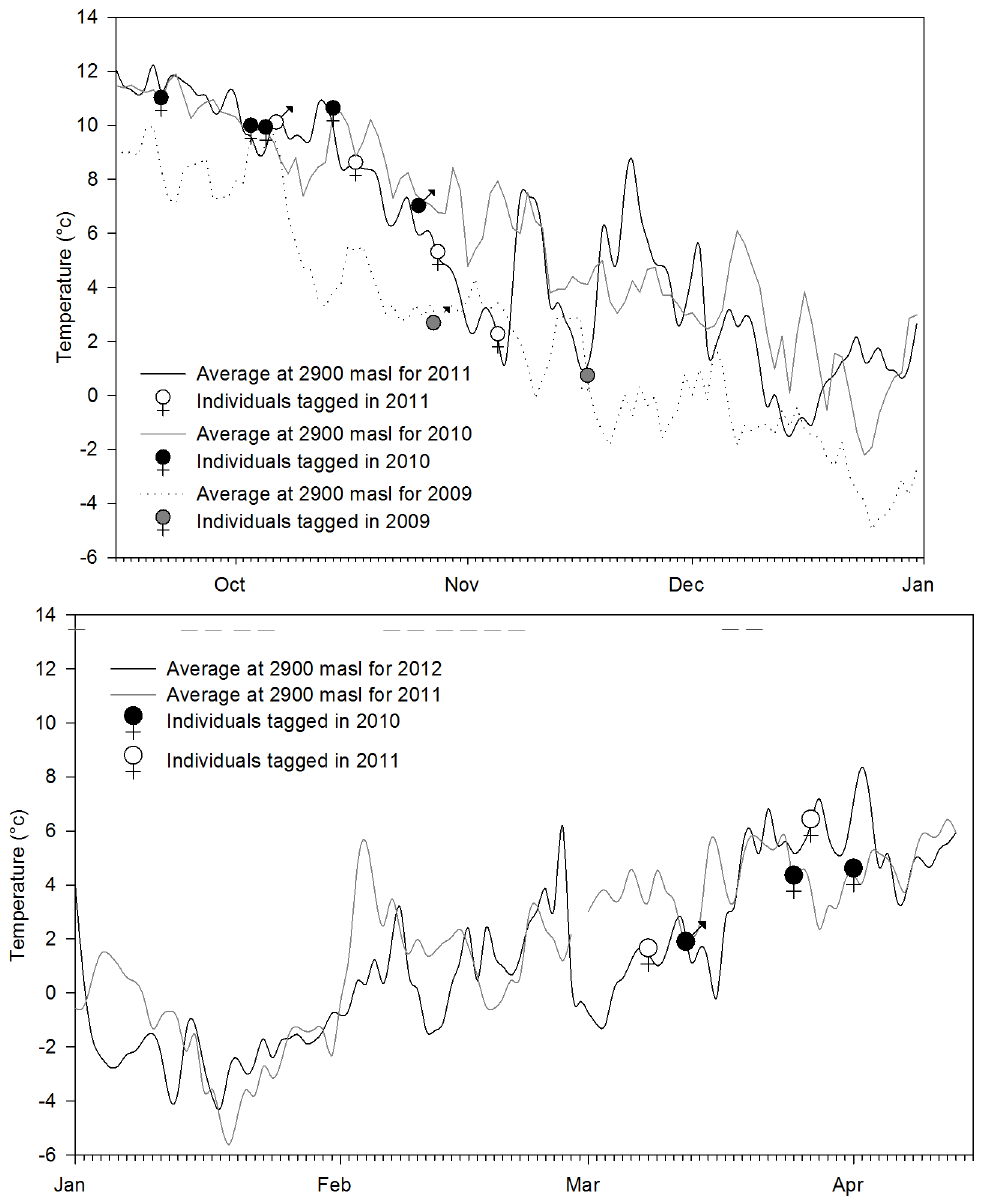
Figure 5. Departure dates for fall migrations for 2009, 2010 and 2011 (A) and return migrations for 2011 and 2012 (B) against temperature profiles. Dashed horizontal grey lines (B) show snowfall days in the study